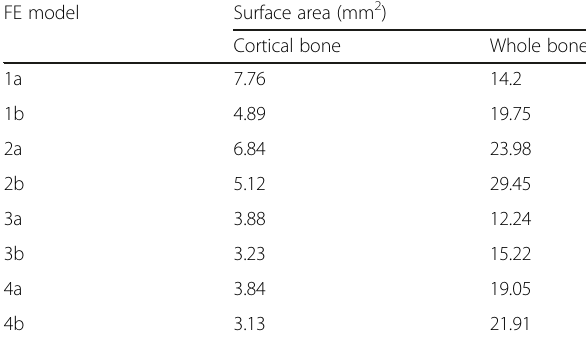
Table 6 Comparison of Surface area (mm 2 ) of cortical bone and whole bone surrounding the